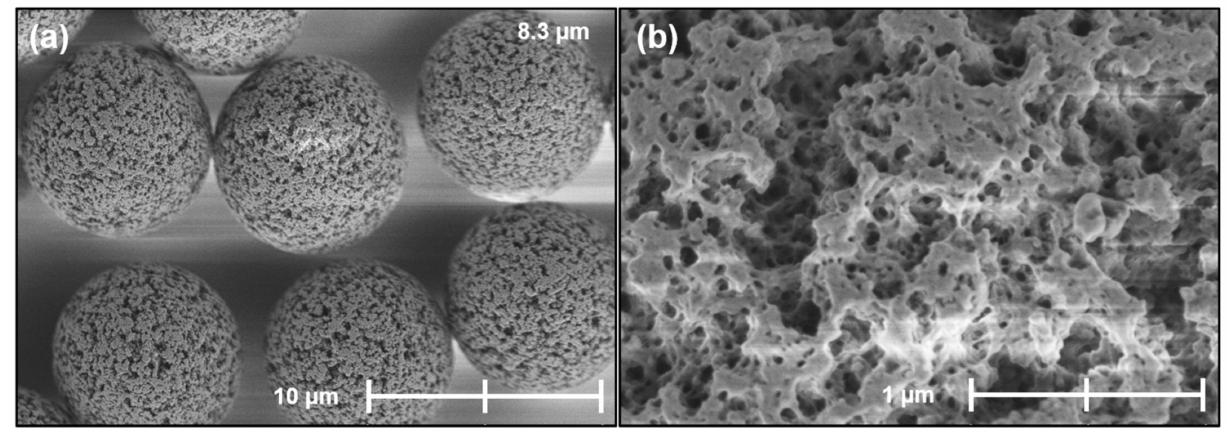
Figure A1. SEM image of p (GMA- co -EDMA) template batch at ( a ) 5000 × and ( b ) 50,000 × magnifica-